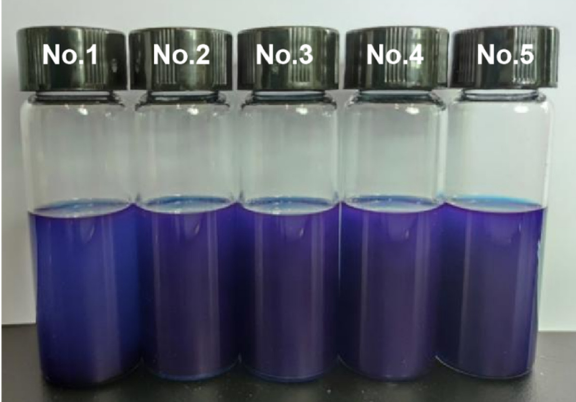
Figure 7. The electrophoretic dispersion was placed for 20 days (No. 1), 15 days (No. 2), 10 days (No. 3), 5 days (No. 4), and 0 days (No. 5).